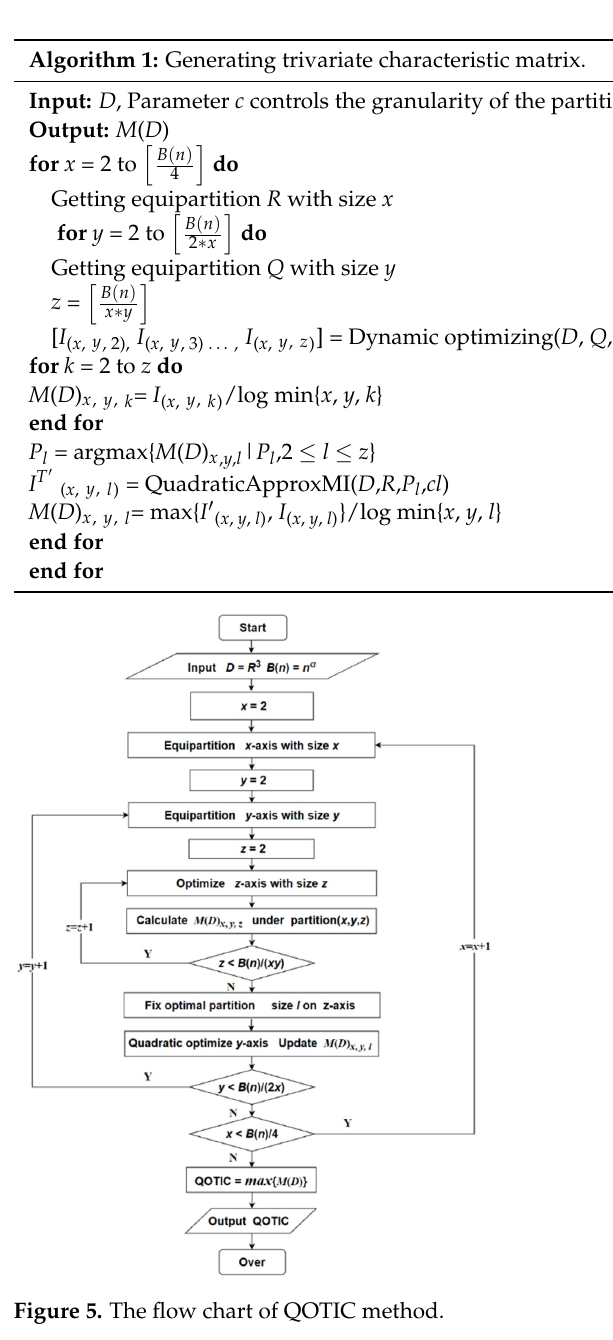
Algorithm 1: Generating trivariate characteristic matrix.